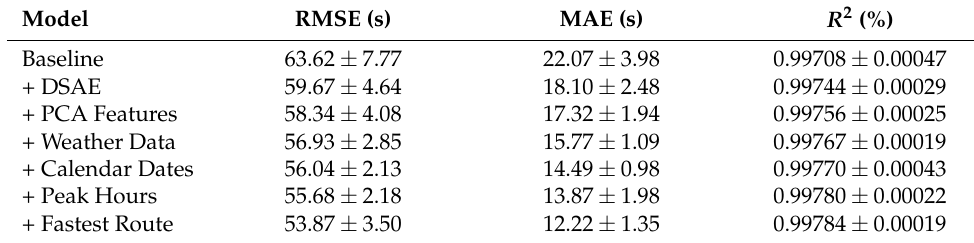
Table 8. The ablation study of our proposed heterogeneous ensemble